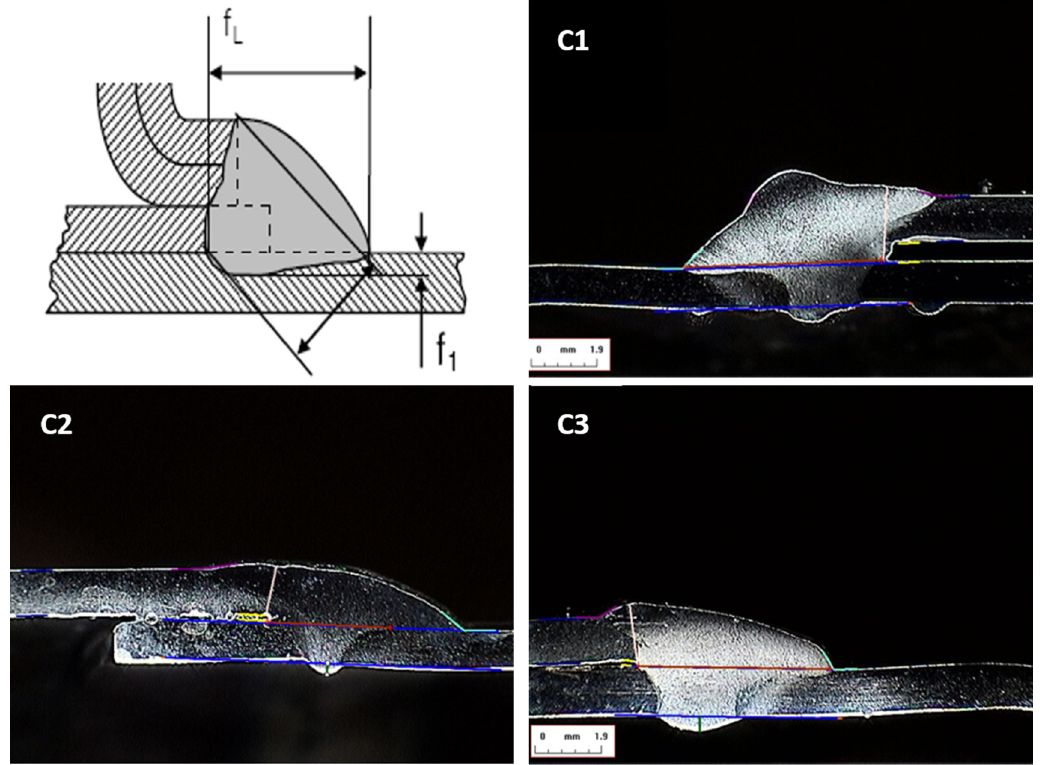
Figure 5. Photographic illustrations of a macrographic analysis with StructureExpert Weld integrated software. Table 3. Parameters observed by StructureExpert Weld software.